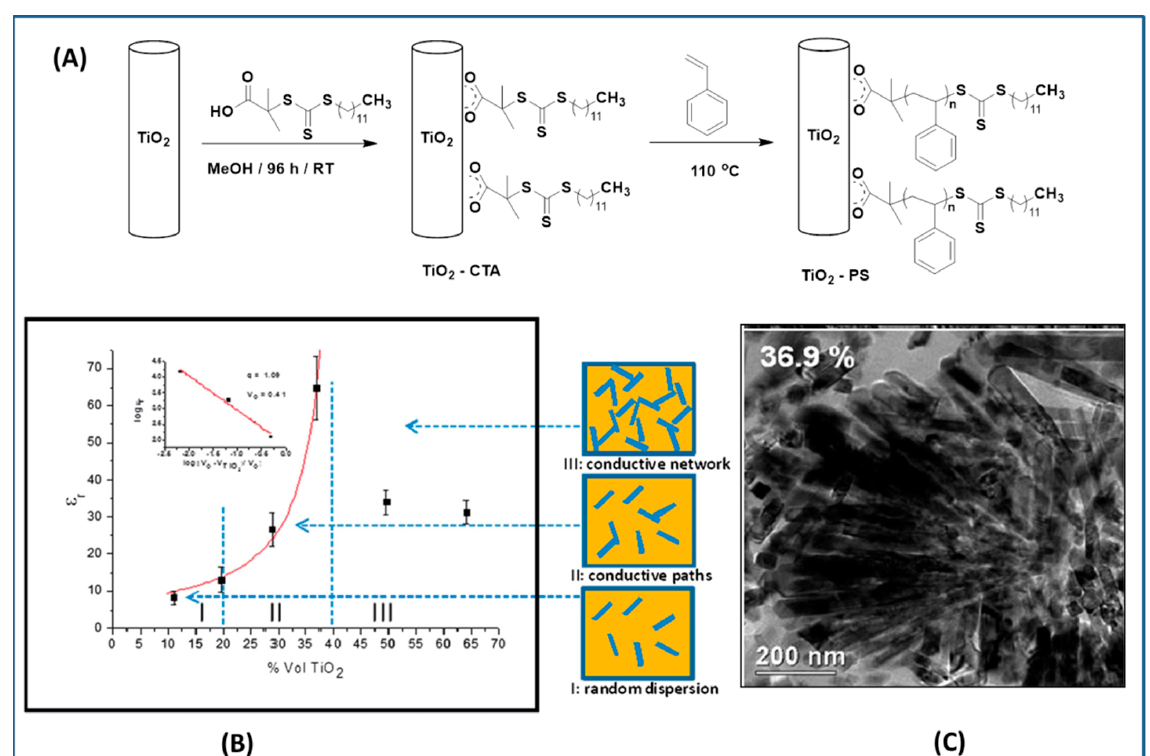
Figure 13. ( A ) Schematic diagram illustrating the process of RAFT polymerization on the surface of rutile nanoparticles; ( B ) Variation of the dielectric constant of the PS@TiO 2 /PS composite V · s. the volume fraction of TiO 2 at 10 4 Hz; ( C ) TEM micrograph of the TiO 2 –PS composites (at 36.9% TiO 2 content). Reproduced with permission from Ref. [138].